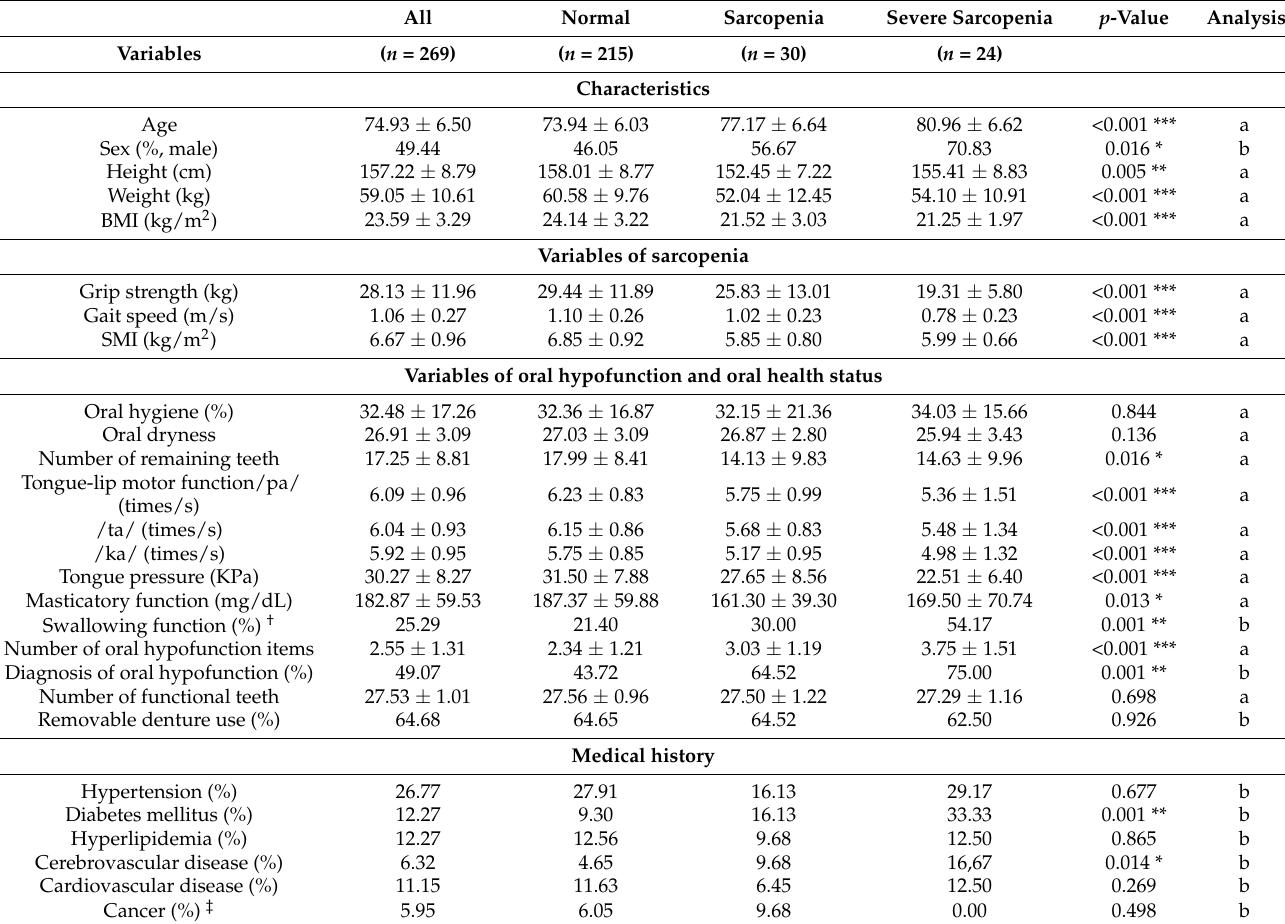
Table 2. Trends in participant characteristics among the study groups.